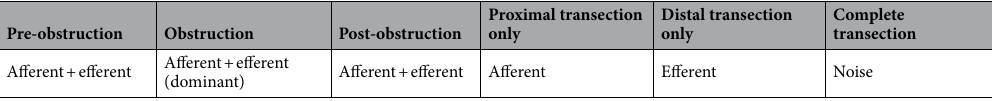
Table 2. Summarizes the efferent or afferent ENG activity associated with different paradigms of ENG recording.